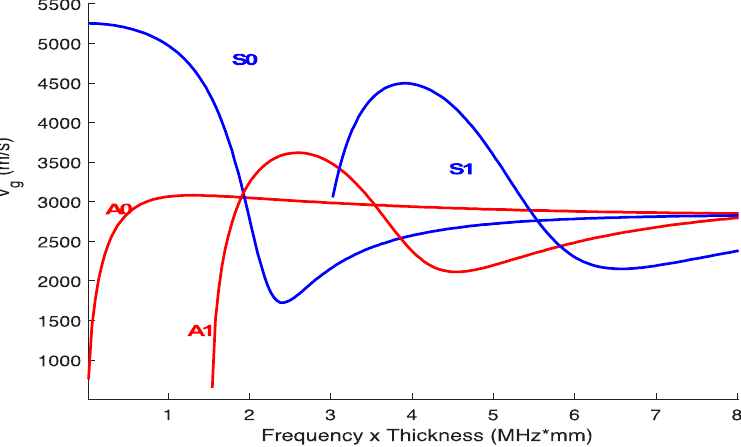
Figure 2. Group velocity dispersion curves for Lamb waves propagating in an aluminum plate. The characteristics of the plate are: Young modulus E = 69 GPa, Poisson ratio ν = 0.34 and density ρ = 2900 kg/m 3 .